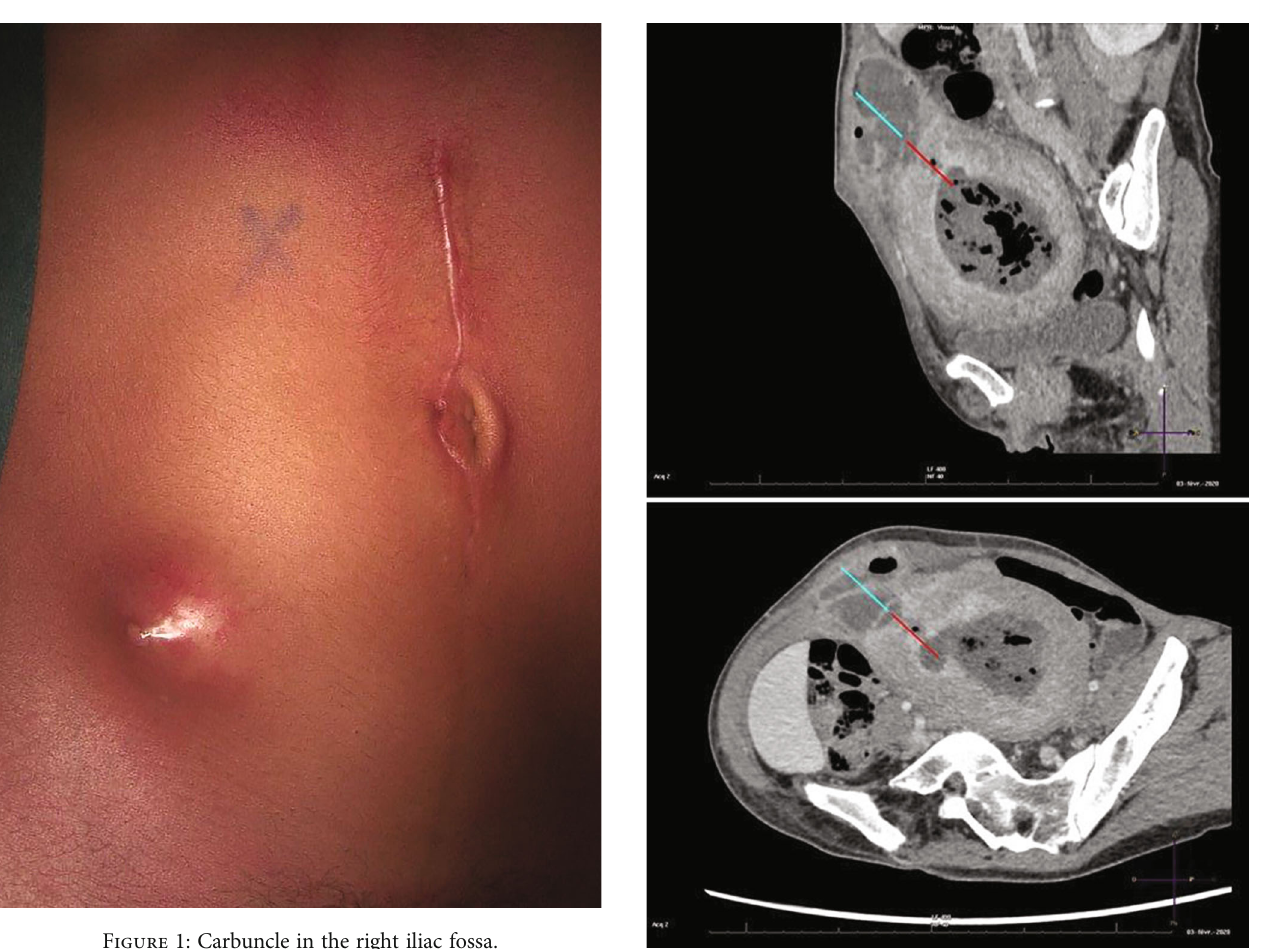
Figure 2: Sagittal and axial MPR reconstruction. Portal phase after iodine contrast injection. The blue arrow shows UCF. The red arrow shows uterine wall